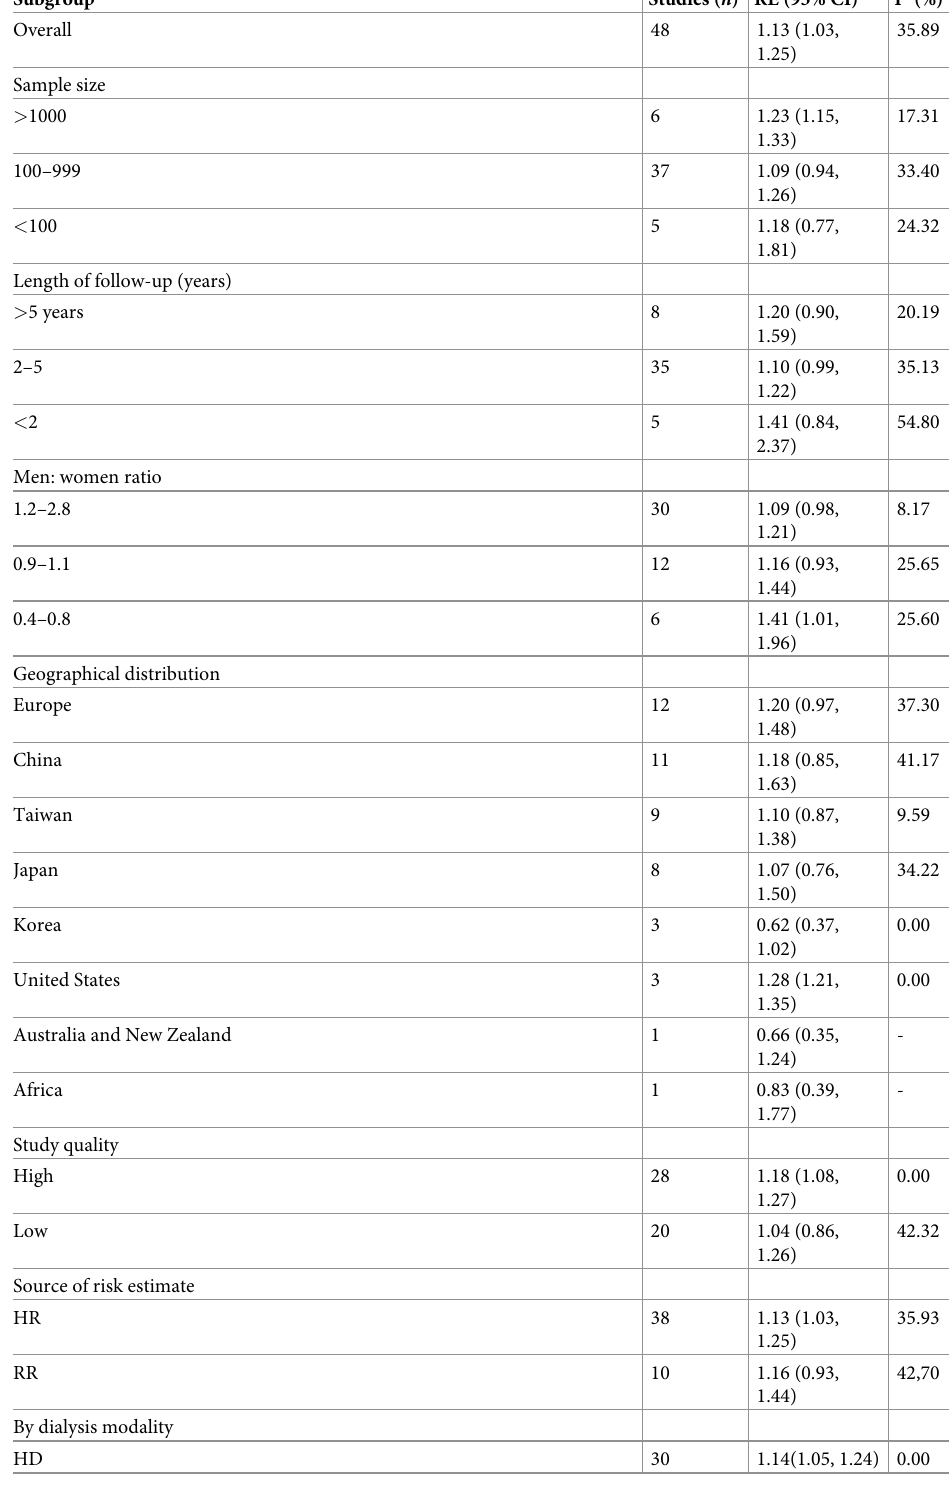
Table 4. Risk estimate (RE) of cardiovascular disease, stratified by study